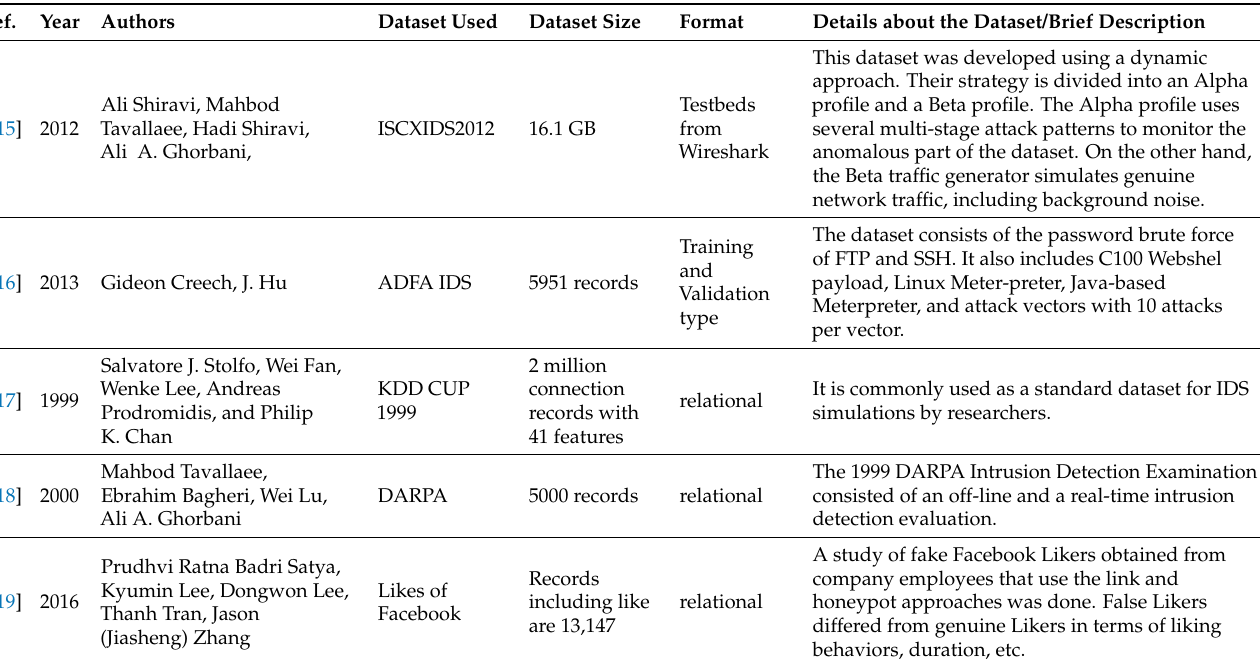
Table 4. List of various Defense Deception